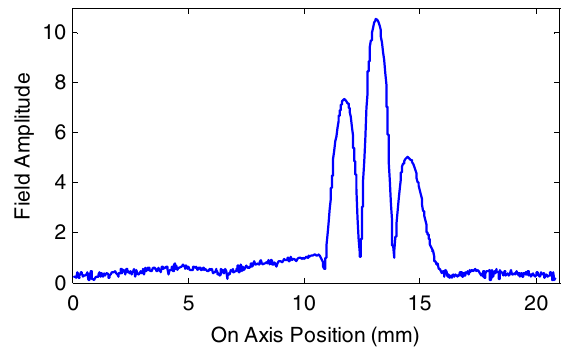
FIG. 2. The (cid:2) -mode electric field profile along the cavity axis, from a bead pull before high-power testing.